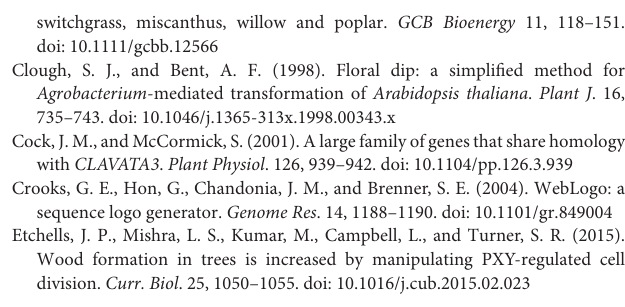
Supplementary Figure 1 | Nucleotide sequences of PvTDIFL3 MR 3 and PvTDIFL3 MR 2 . The nucleotide sequences were obtained by clones. Green, blue, and pink font represent 5 ′ -UTR, CDS, and 3 ′ -UTR, respectively. The sequences corresponding to the TDIFL motifs are underlined. Supplementary Figure 2 | Weblogo images of CLE motifs from six groups in Arabidopsis and switchgrass. Weblogo images were created by using the Weblogo online tool with the amino acid sequences from the predicted CLE motifs. Supplementary Table 1 | Amino acid sequences from TDIF/TDIFL used for chemical synthesis. Supplementary Table 2 | Primers used in this study. Supplementary Table 3 | Information of PvCLE proteins identified in this